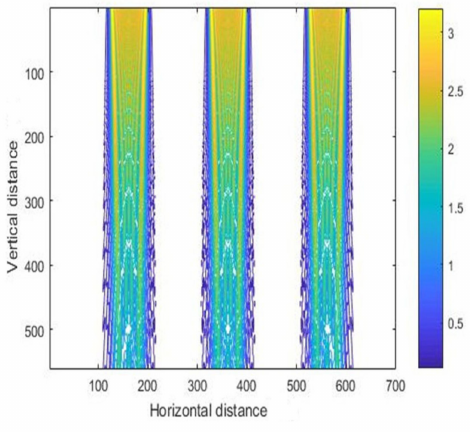
Figure 8. The contour map of intensity distribution for vertical